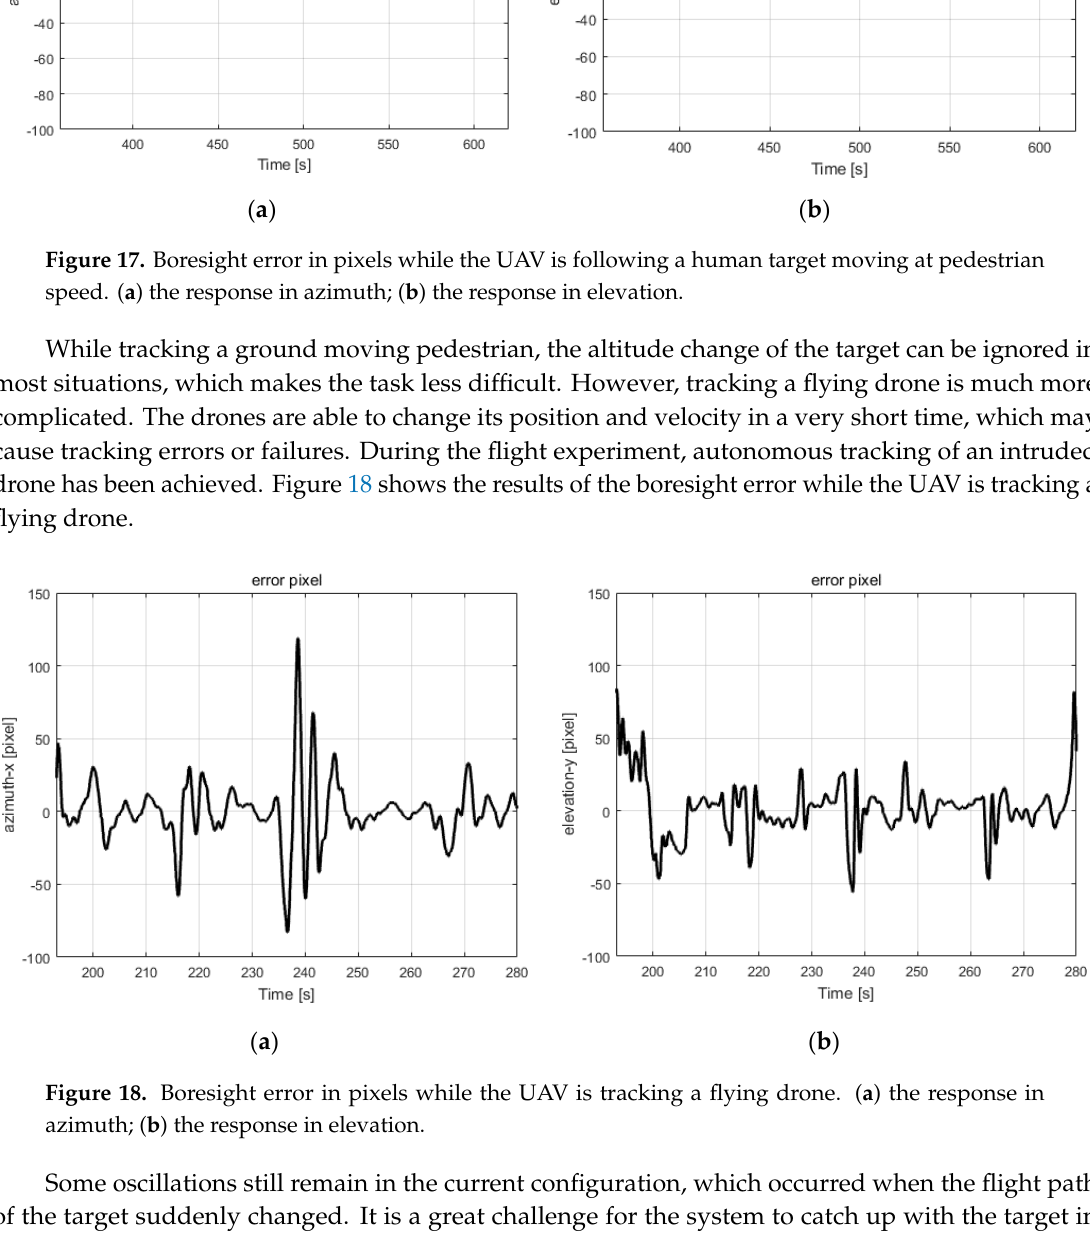
Table 1. Root mean square errors (RMSEs) of boresight errors in different cases.